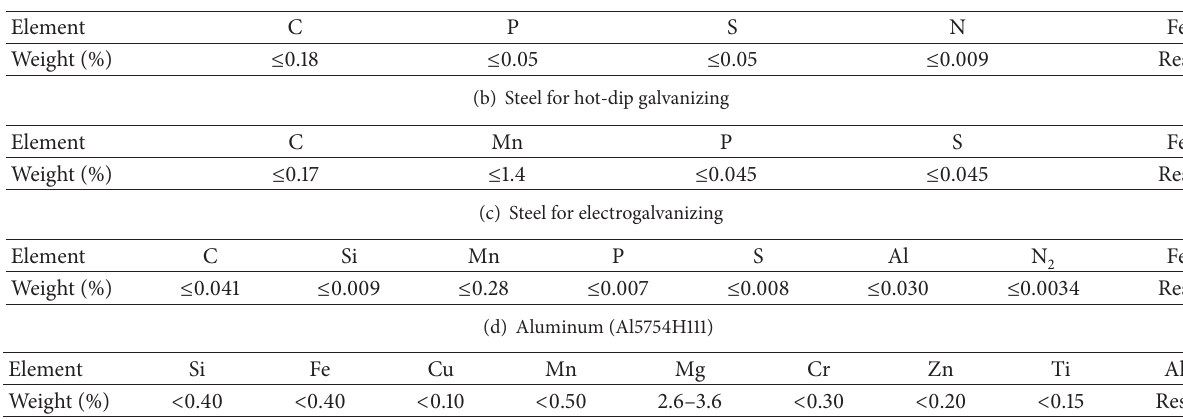
Table 1: Chemical composition of the used substrates.